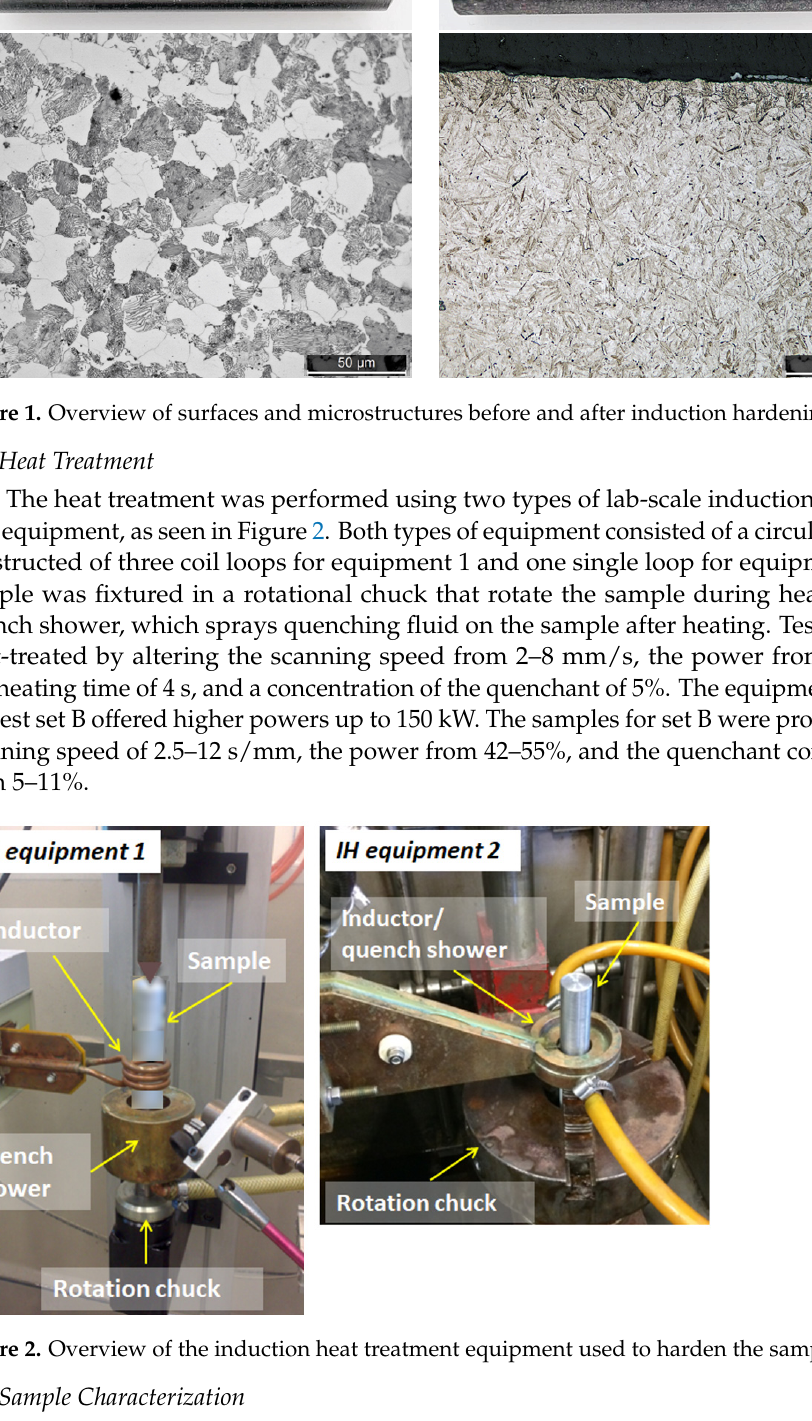
Figure 2. Overview of the induction heat treatment equipment used to harden the samples.